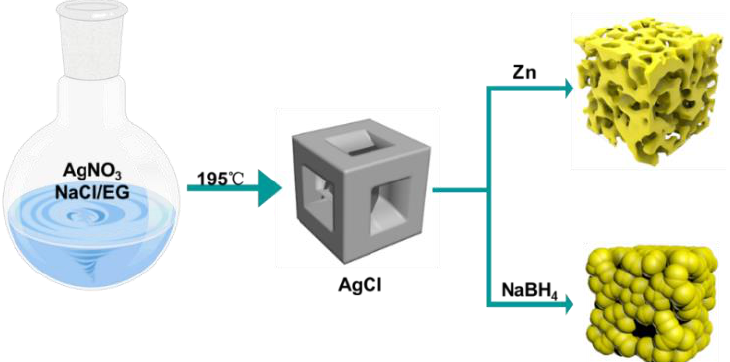
Figure 1. Schematic diagram of the preparation process for granular and sponge-like Ag cubes.